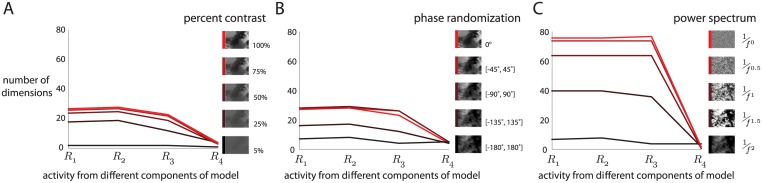
Dimensionality of model responses to parametrically-altered versions of the images in the natural movie.A: Images were generated by gradually decreasing contrast of the original images. B: Images were generated by adding a random offset to the phases of the original images, which transformed the natural images to pink noise. Each random offset was drawn from a uniform distribution over the specified range. C: Images were generated by raising the power spectrum of the same pink noise images generated in B to a fractional exponent. This gradually transformed the pink noise images to white noise.